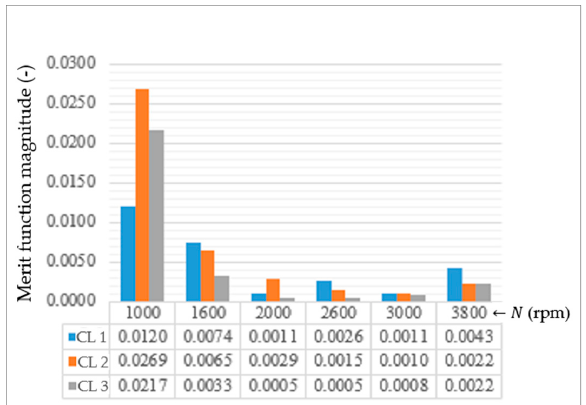
Figure 14. Magnitude of the merit function at six engine full ‐ load steady ‐ state operating points for CLs 1–3.